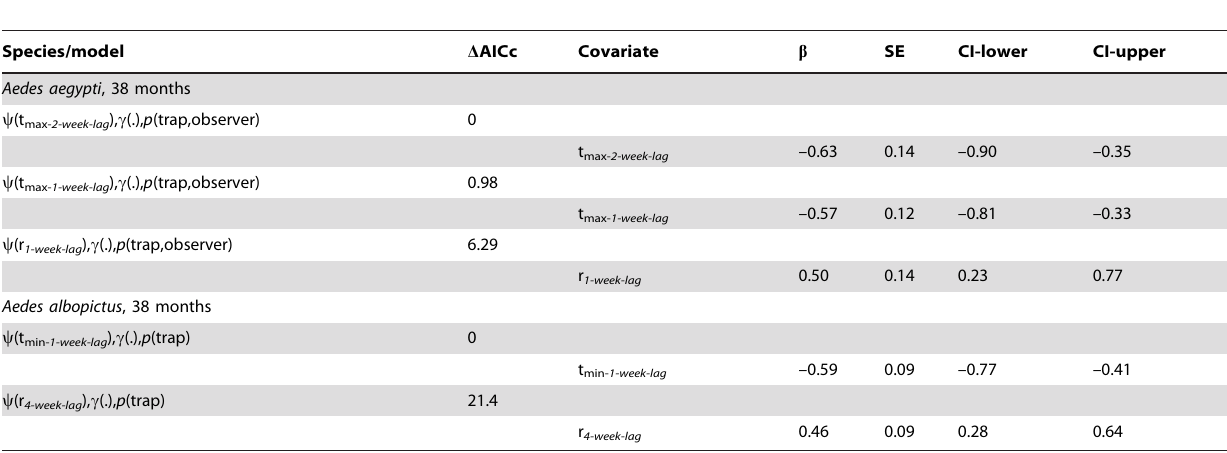
Table 2. Meteorological covariate effects on dwelling infestation rates by Aedes aegypti and Ae. albopictus : dynamic site- occupancy models fitted to a 38-month